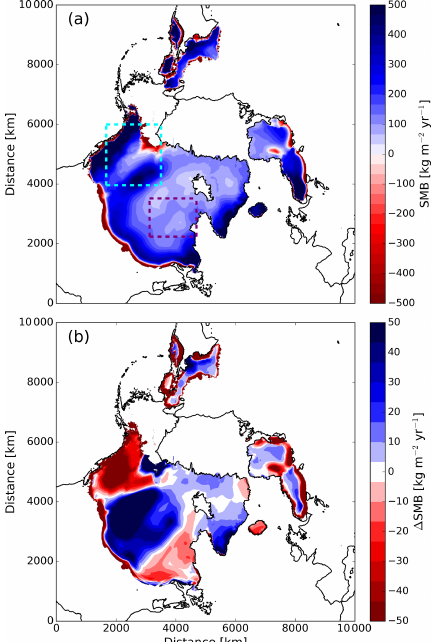
Figure A2. (a) Mean SMB field for one cycle of the idealised forc- ing. (b) Difference in SMB before and after a surge event for one cycle of the idealised forcing. Cyan and purple dashed boxes in (a) show Mackenzie and Hudson area,